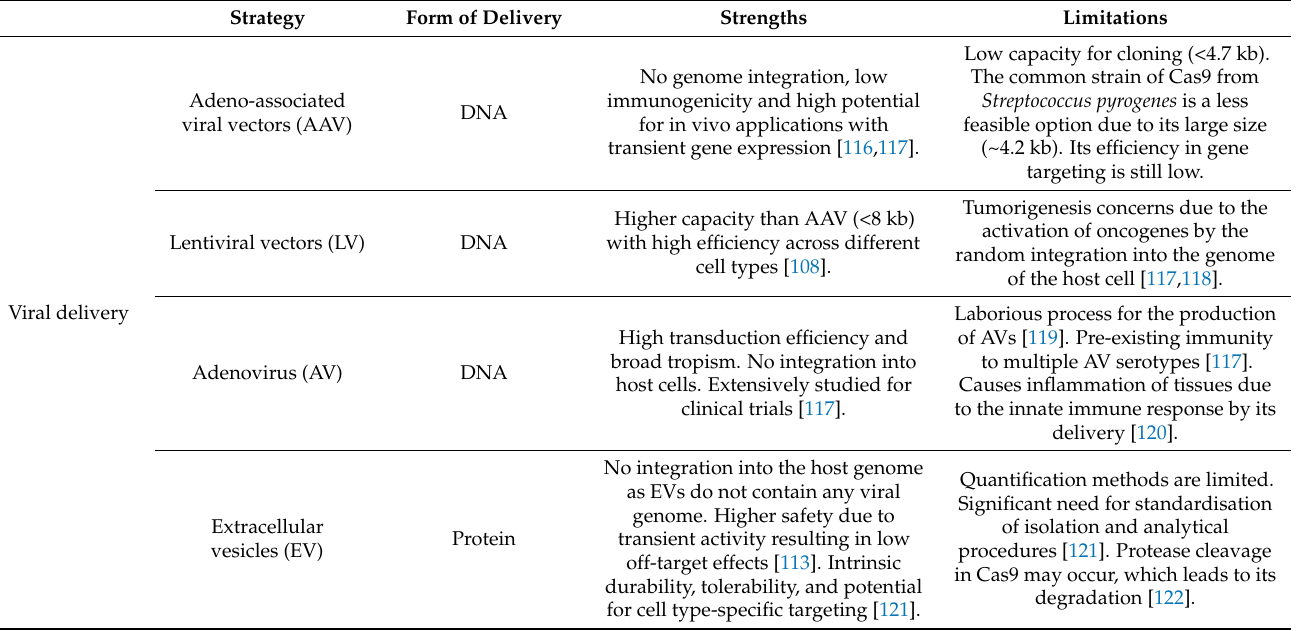
Table 5. Summary of the most common delivery systems in CRISPR-Cas systems. Strategy Form of